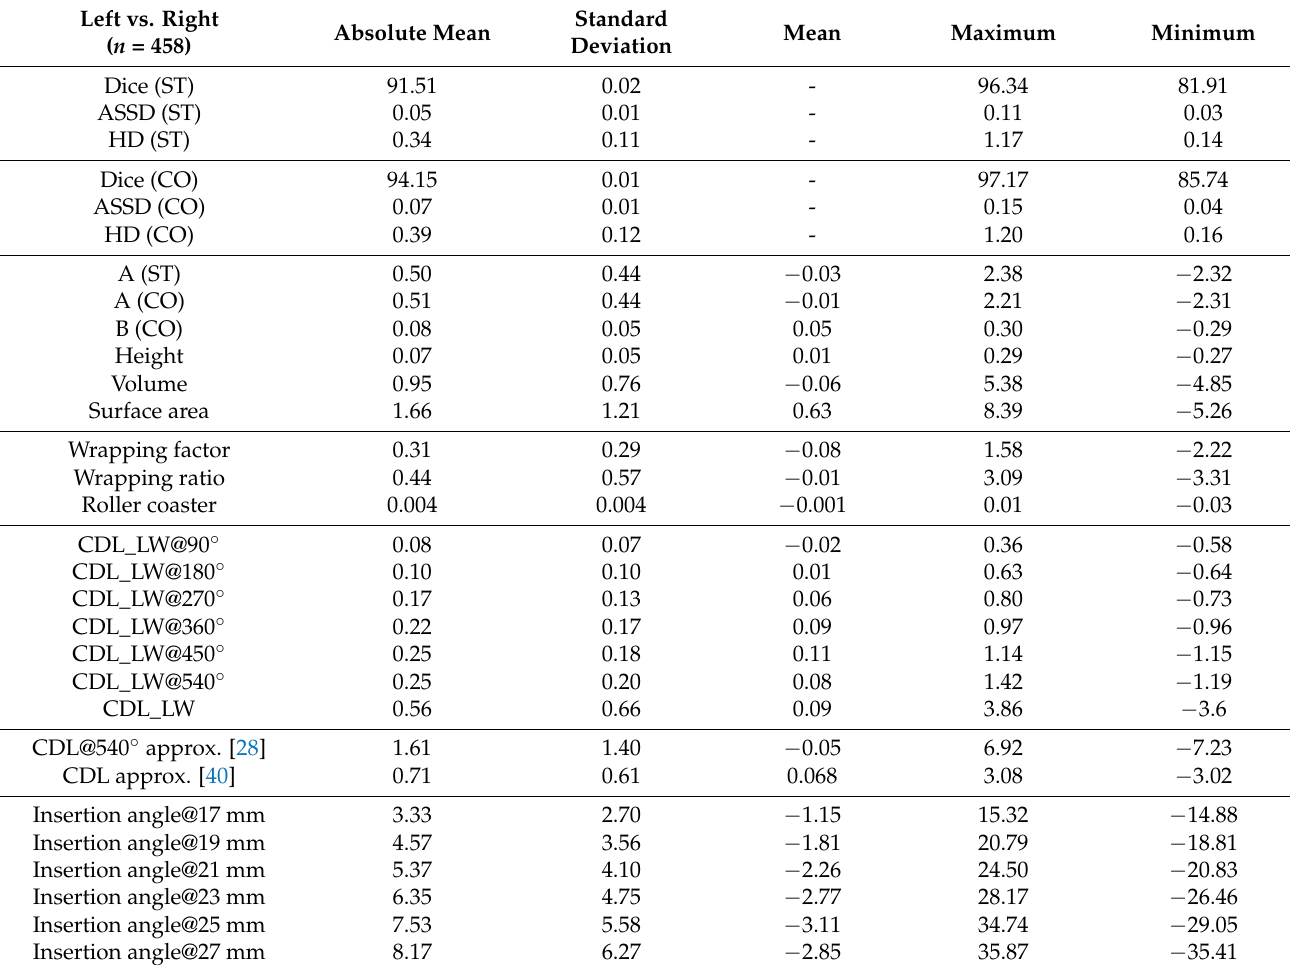
Table 1. Intra-patient analysis of imaging and clinical parameters. Positive values in the mean column represent a larger right cochlea and vice versa. ASSD: average symmetric surface distance;